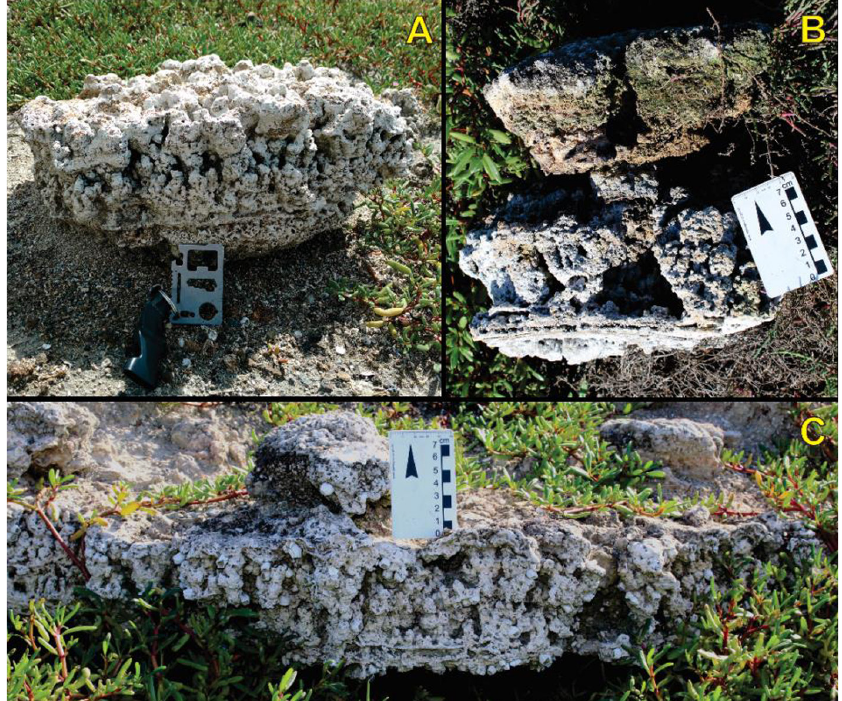
Figure 6 - Exposure of columnar branched stromatolites. A) Outcropping biostructure in life position; B) Remobilized stromatolites; C) Biostructure arranged in slabs (Adapted from Silva